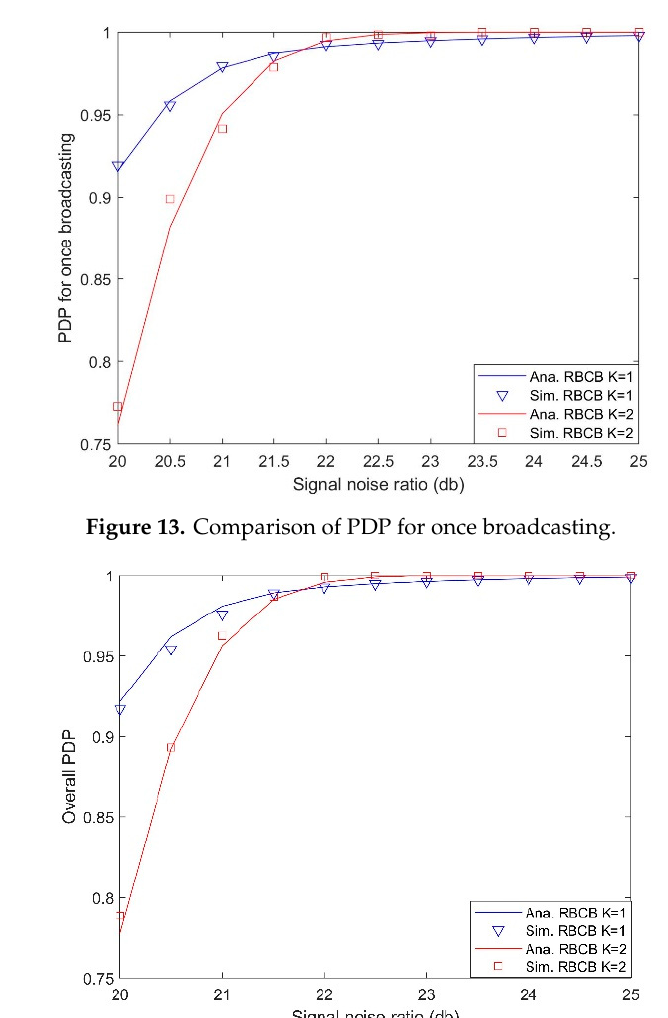
Figure 14. Comparison of the overall PDP.